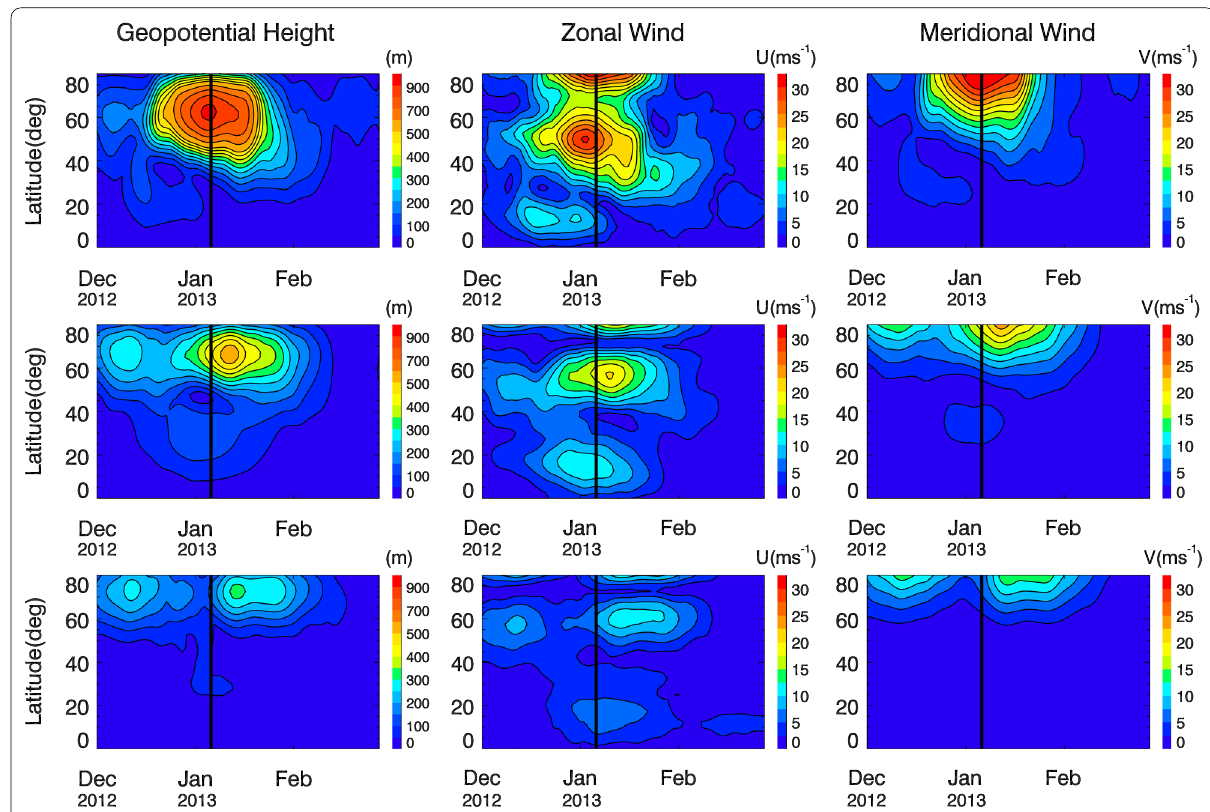
Fig. 8 Latitude versus time structures of the W1 Q16DW amplitudes for the geopotential height (left), zonal wind (middle) and meridional wind (right) at three pressure levels: 1 hPa (top), 10 hPa (middle) and 30 hPa (bottom). The thick vertical line denotes the SSW central date